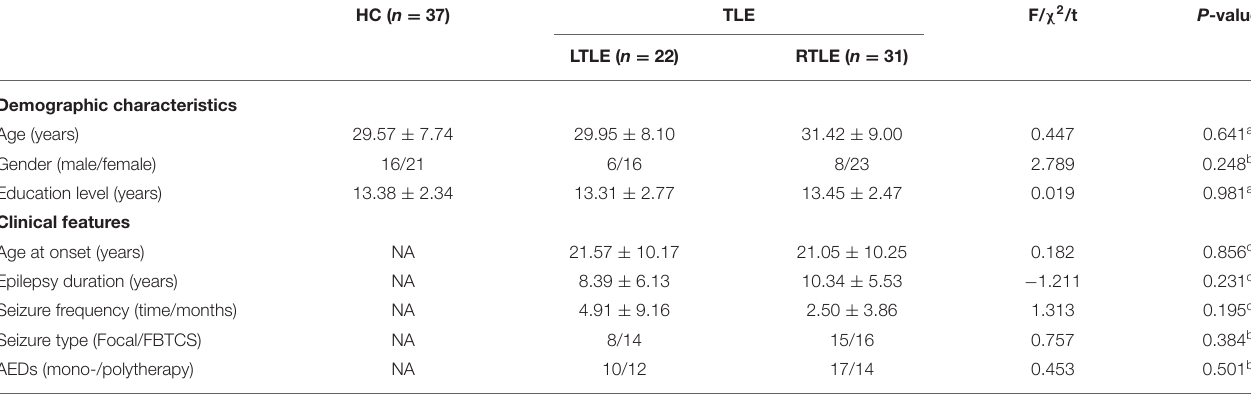
TABLE 1 | Demographic characteristics and clinical features of patients with TLE and healthy